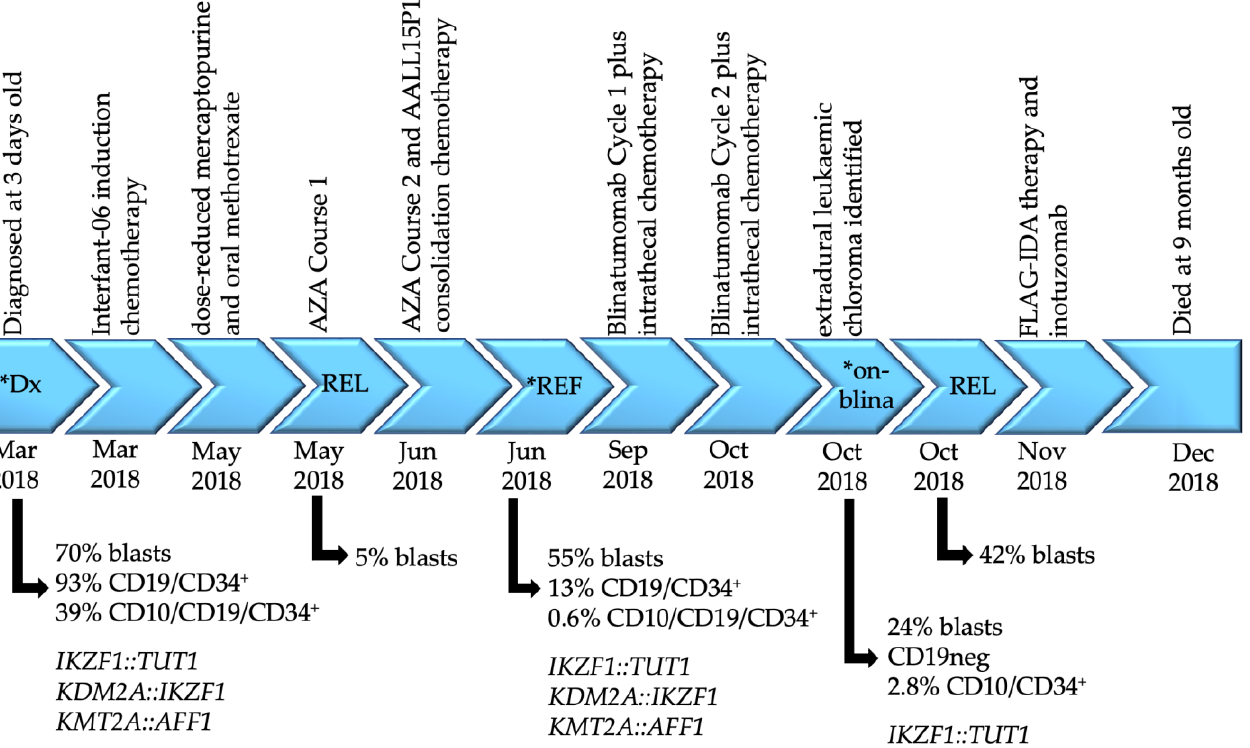
Figure 1. Disease timeline of patient CHI_0391. Disease timepoints, associated treatments, blast percentages with the corresponding immunophenotype where available and gene fusions identified by mRNA-Seq are indicated. Asterisks denote the samples analyzed by transcriptomic sequencing in this report. Interfant-06 induction chemotherapy includes prednisone, dexamethasone, vincristine, cytarabine, daunorubicin, PEG-asparaginase, methotrexate, bortezomib and melphalan; AALL15P1 consolidation protocol includes cyclophosphamide, mercaptopurine, cytarabine, methotrexate,